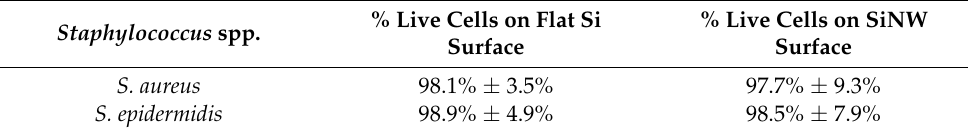
Table 1. Fraction of live cells on flat Si and SiNW surfaces 1 .